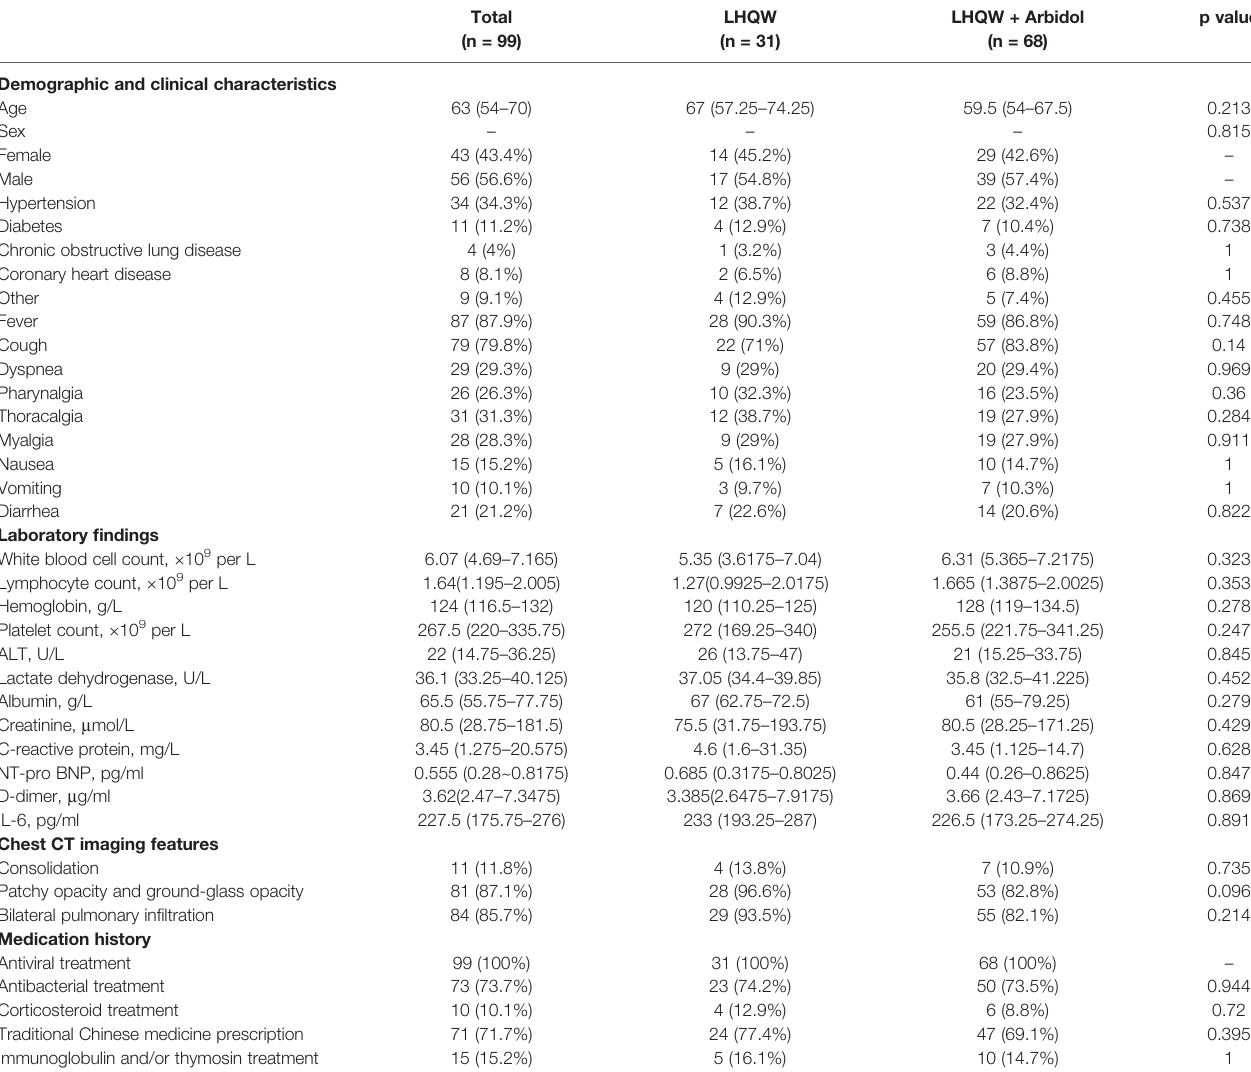
TABLE 3 | Demographic, clinical, laboratory, and radiographic characteristics and the medication history of patients with moderate